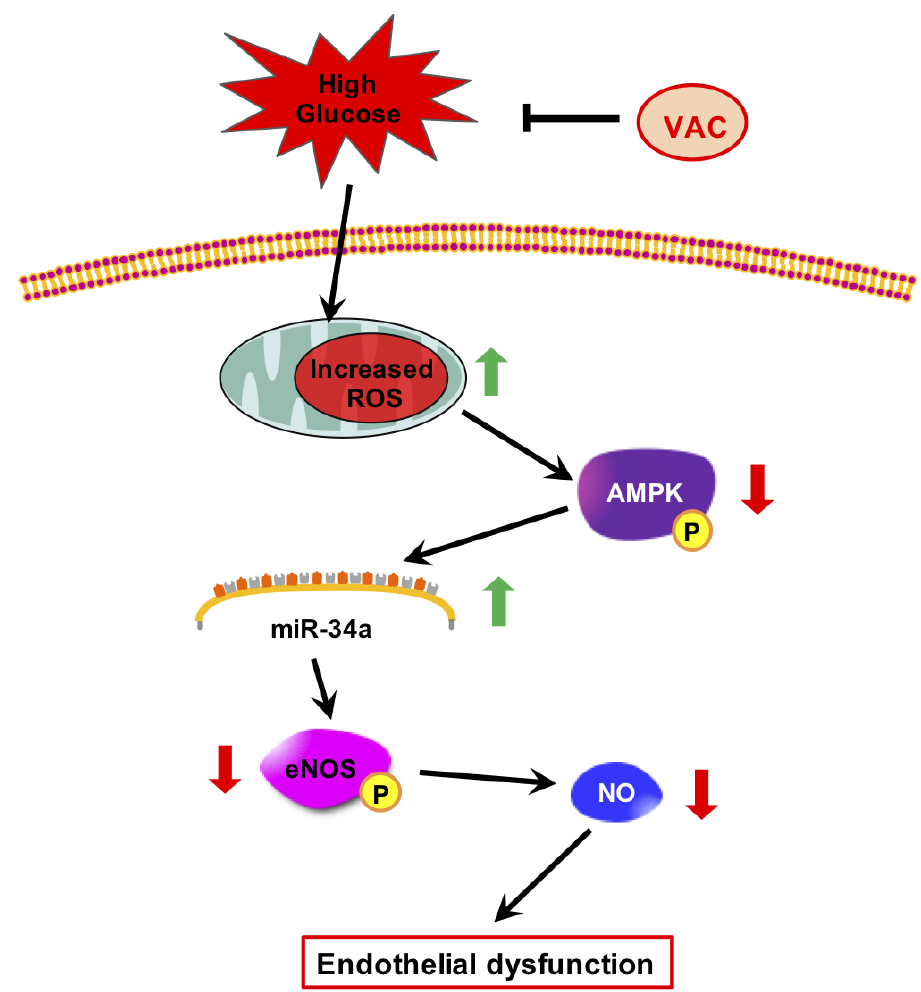
Figure 7. Protective mechanisms of vaccarin against high glucose-induced endothelial injury.